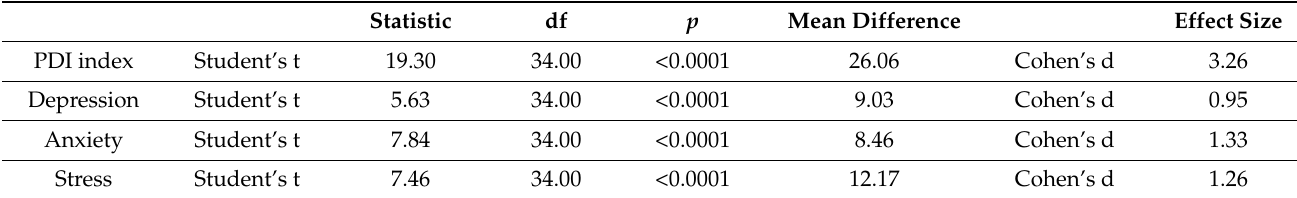
Table 3. One sample t -test analysis on emotional dimensions of ESRD patients.